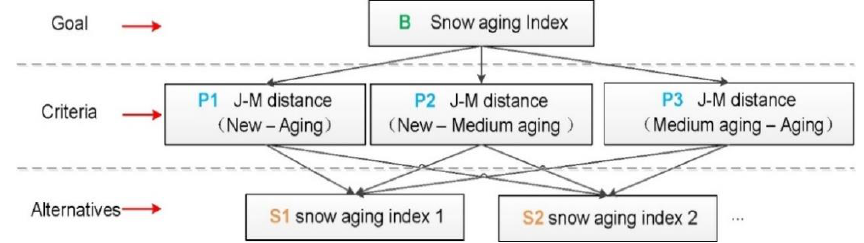
Figure 6. Affinity Diagram of AHP for SAI. Figure 6. A ffi nity Diagram of AHP for